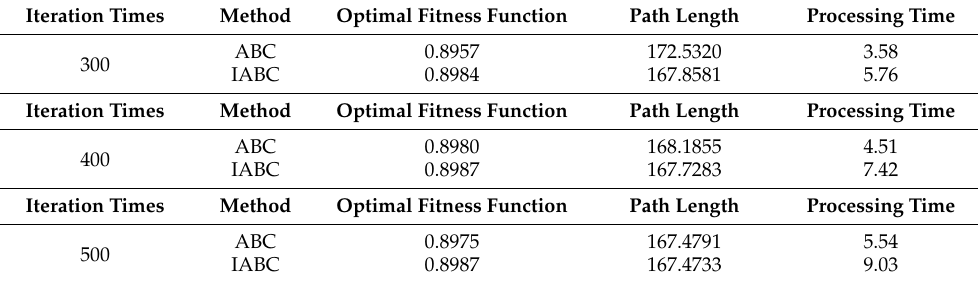
Table 8. Evaluation results of ABC and IABC using different indices and iteration